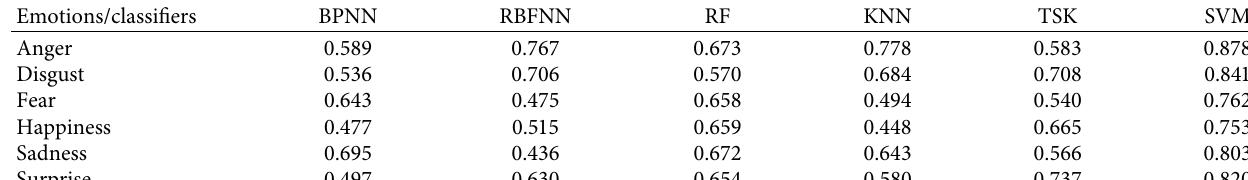
Table 2: Expression-based emotion recognition results.